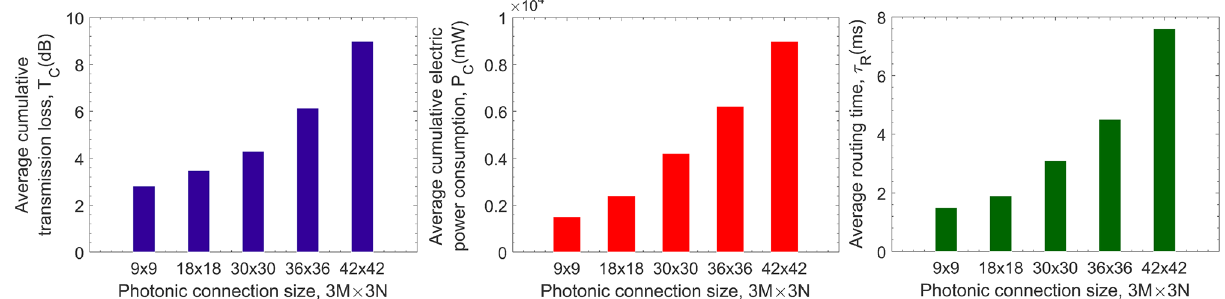
Figure 14. Performance of the learned routing policy as the size of the photonic chip network increases, in terms of transmission loss (a) , power consumption (b) , and routing time (c)